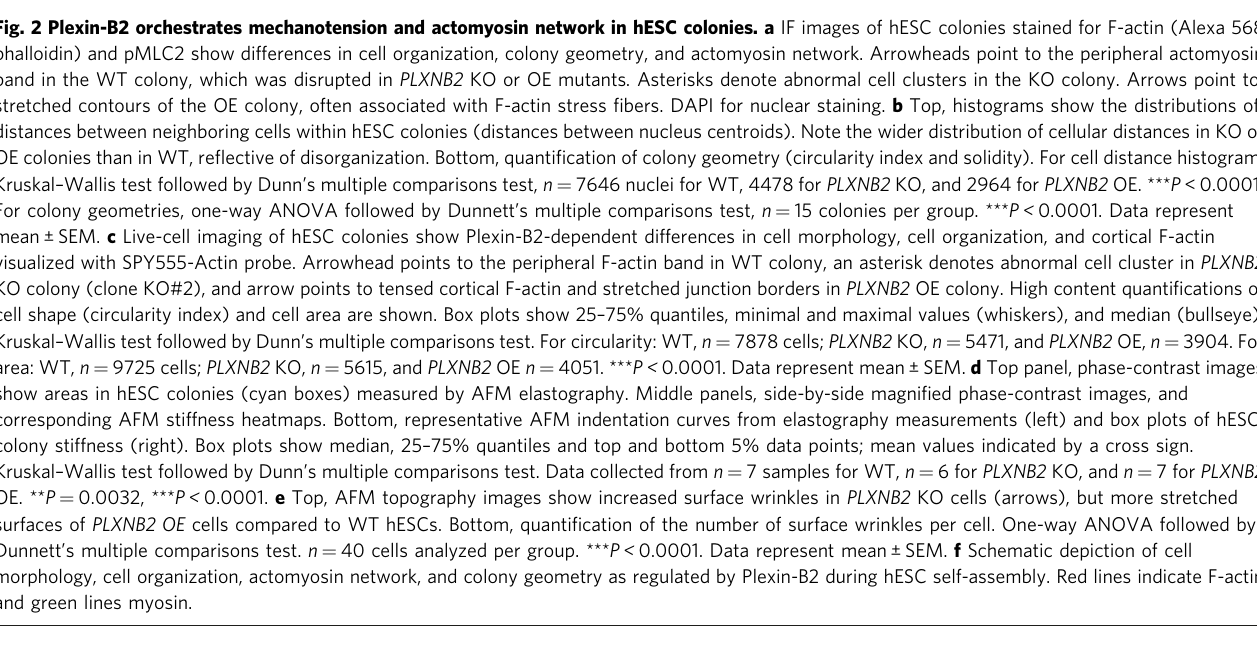
Fig. 2 Plexin-B2 orchestrates mechanotension and actomyosin network in hESC colonies. a IF images of hESC colonies stained for F-actin (Alexa 568 phalloidin) and pMLC2 show differences in cell organization, colony geometry, and actomyosin network. Arrowheads point to the peripheral actomyosin band in the WT colony, which was disrupted in PLXNB2 KO or OE mutants. Asterisks denote abnormal cell clusters in the KO colony. Arrows point to stretched contours of the OE colony, often associated with F-actin stress fi bers. DAPI for nuclear staining. b Top, histograms show the distributions of distances between neighboring cells within hESC colonies (distances between nucleus centroids). Note the wider distribution of cellular distances in KO or OE colonies than in WT, re fl ective of disorganization. Bottom, quanti fi cation of colony geometry (circularity index and solidity). For cell distance histogram, Kruskal – Wallis test followed by Dunn ’ s multiple comparisons test, n = 7646 nuclei for WT, 4478 for PLXNB2 KO, and 2964 for PLXNB2 OE. *** P < 0.0001. For colony geometries, one-way ANOVA followed by Dunnett ’ s multiple comparisons test, n = 15 colonies per group. *** P < 0.0001. Data represent mean ± SEM. c Live-cell imaging of hESC colonies show Plexin-B2-dependent differences in cell morphology, cell organization, and cortical F-actin visualized with SPY555-Actin probe. Arrowhead points to the peripheral F-actin band in WT colony, an asterisk denotes abnormal cell cluster in PLXNB2 KO colony (clone KO#2), and arrow points to tensed cortical F-actin and stretched junction borders in PLXNB2 OE colony. High content quanti fi cations of cell shape (circularity index) and cell area are shown. Box plots show 25 – 75% quantiles, minimal and maximal values (whiskers), and median (bullseye). Kruskal – Wallis test followed by Dunn ’ s multiple comparisons test. For circularity: WT, n = 7878 cells; PLXNB2 KO, n = 5471, and PLXNB2 OE, n = 3904. For area: WT, n = 9725 cells; PLXNB2 KO, n = 5615, and PLXNB2 OE n = 4051. *** P < 0.0001. Data represent mean ± SEM. d Top panel, phase-contrast images show areas in hESC colonies (cyan boxes) measured by AFM elastography. Middle panels, side-by-side magni fi ed phase-contrast images, and corresponding AFM stiffness heatmaps. Bottom, representative AFM indentation curves from elastography measurements (left) and box plots of hESC colony stiffness (right). Box plots show median, 25 – 75% quantiles and top and bottom 5% data points; mean values indicated by a cross sign. Kruskal – Wallis test followed by Dunn ’ s multiple comparisons test. Data collected from n = 7 samples for WT, n = 6 for PLXNB2 KO, and n = 7 for PLXNB2 OE. ** P = 0.0032, *** P < 0.0001. e Top, AFM topography images show increased surface wrinkles in PLXNB2 KO cells (arrows), but more stretched surfaces of PLXNB2 OE cells compared to WT hESCs. Bottom, quanti fi cation of the number of surface wrinkles per cell. One-way ANOVA followed by Dunnett ’ s multiple comparisons test. n = 40 cells analyzed per group. *** P < 0.0001. Data represent mean ± SEM. f Schematic depiction of